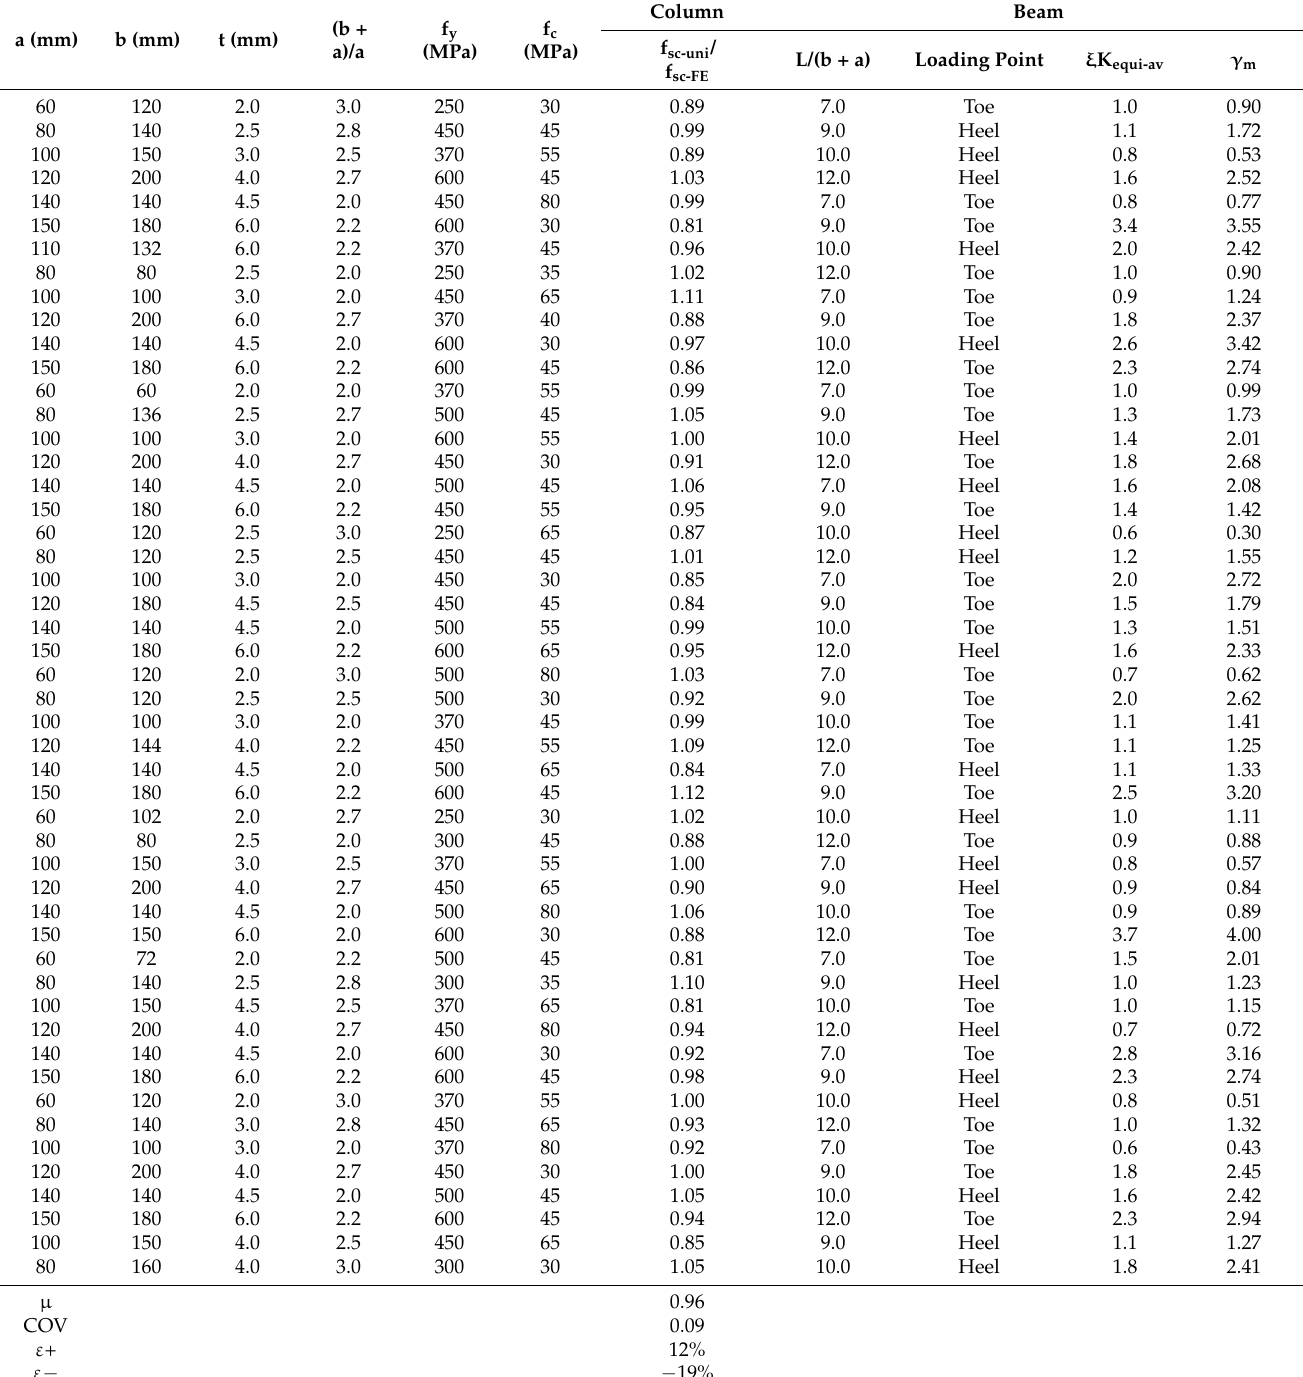
Table A1. Details on the 50 ML-CFST stub column and 50 ML-CFST beam